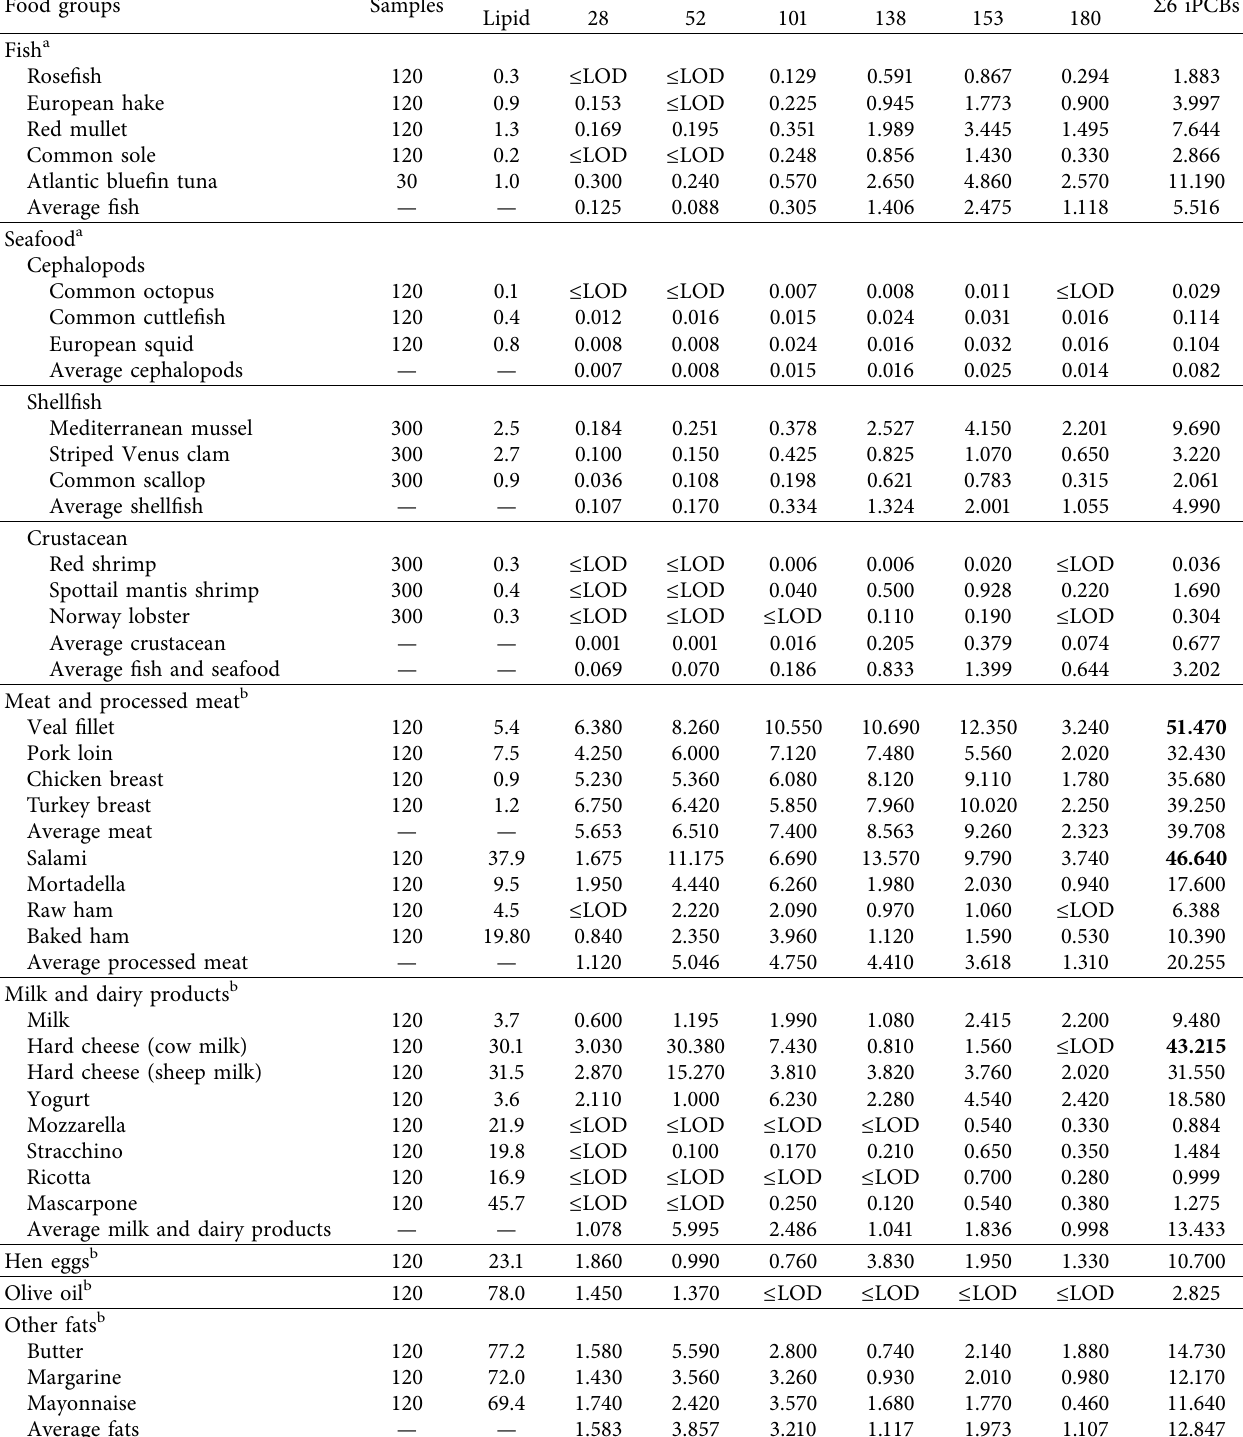
Table 2: Concentrations of individual iPCBs (ngg − 1 ) and their sum ( Σ 6